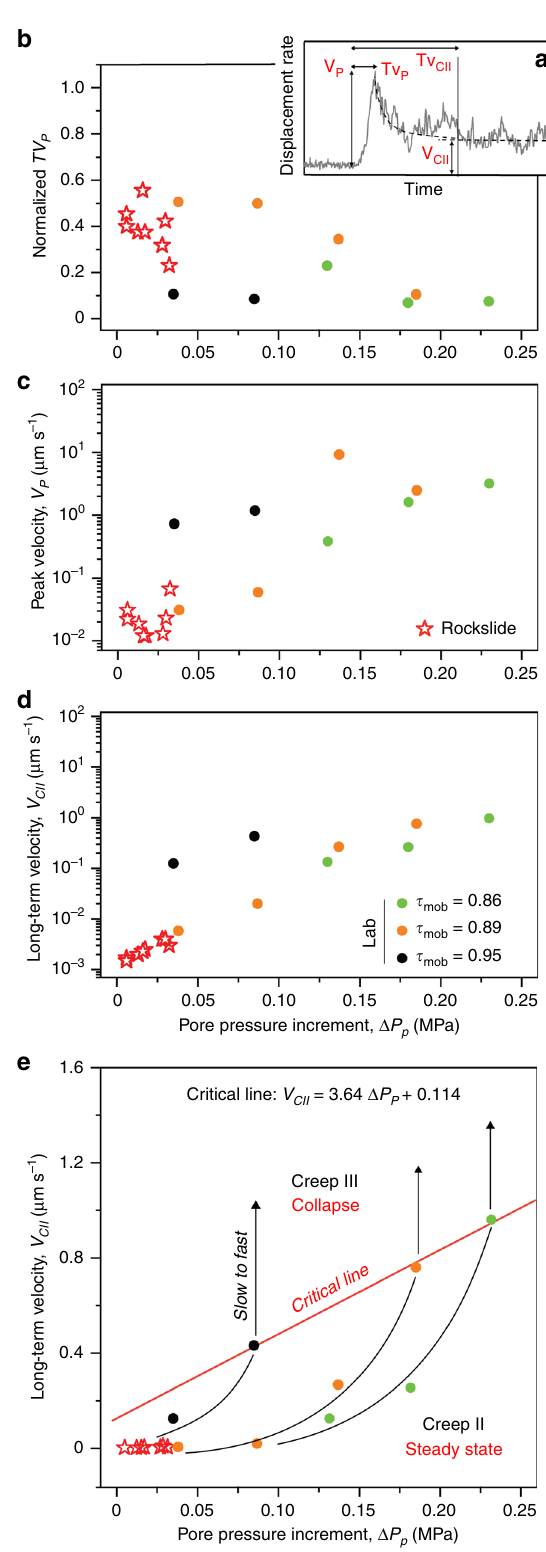
Fig. 5 Laboratory vs in situ undrained response to short-term pore- pressure increase. a Key descriptors for the system response to pore- pressure increments, Δ P p ; b normalized time to reach peak velocity ( TV P ); ( c ) peak velocity ( V P ); d long-term Creep II-velocity ( V CII ); e description of the rockslide path towards catastrophic collapse and threshold conditions (Critical Line; linear fi t R 2 : 0.992, p -value: 0.057) as a function of V CII and pore-pressure